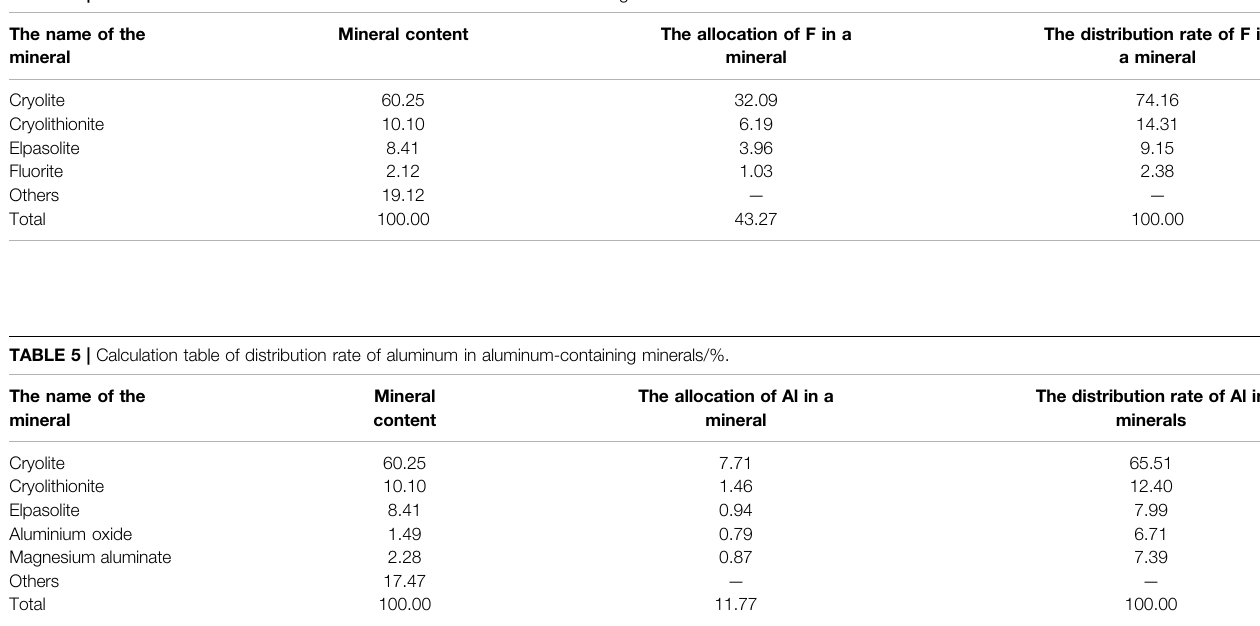
The distribution rate of F in a mineral